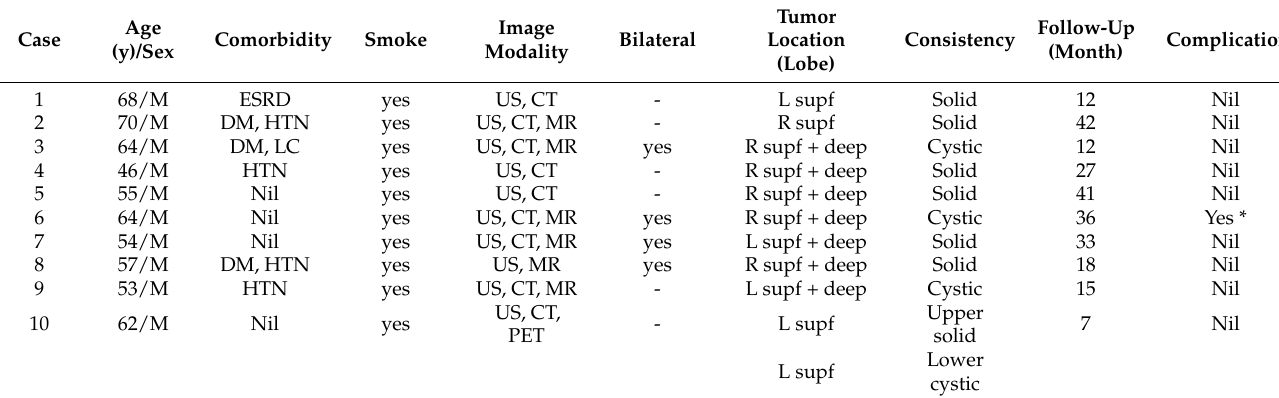
Table 1. Demographic Information of Patients with Warthin